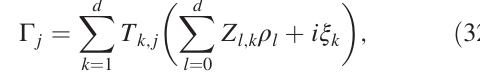
FIG. 3. Pseudocode to generate a lower bound to the HCRB for multiple parameters. The pseudocode to generate the Lagrange dual functions is shown in Fig.